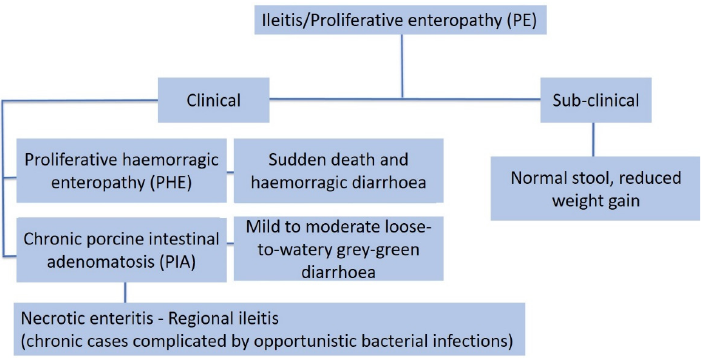
Figure 20. Clinical presentation of proliferative enteropathy (modified from D’Annunzio et al., 2021) [81].